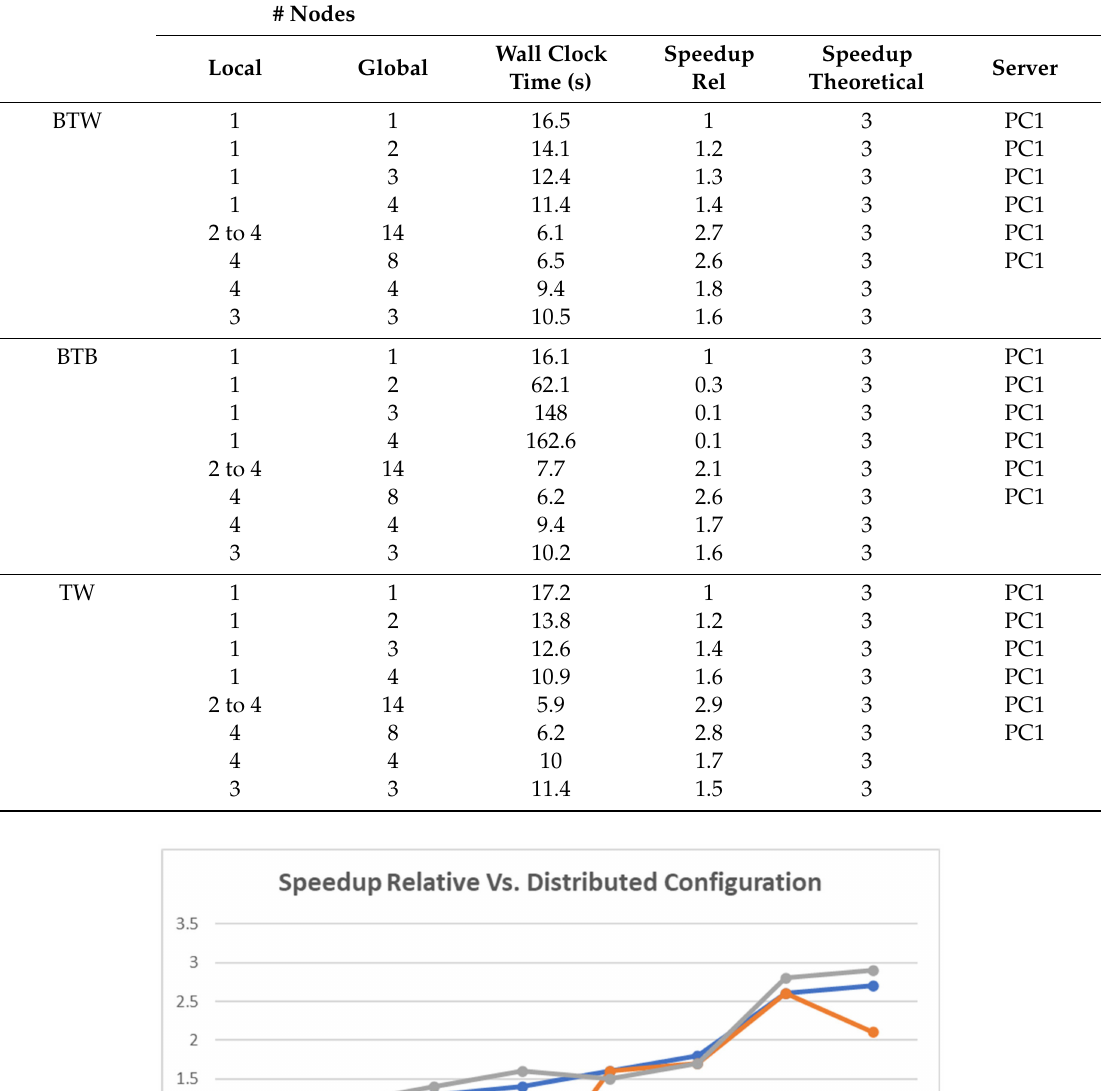
Table 3. Example of simulation runs (variations) with di ff erent configurations and their respective wall-clock times for the case study depicted in Figures 7–10.